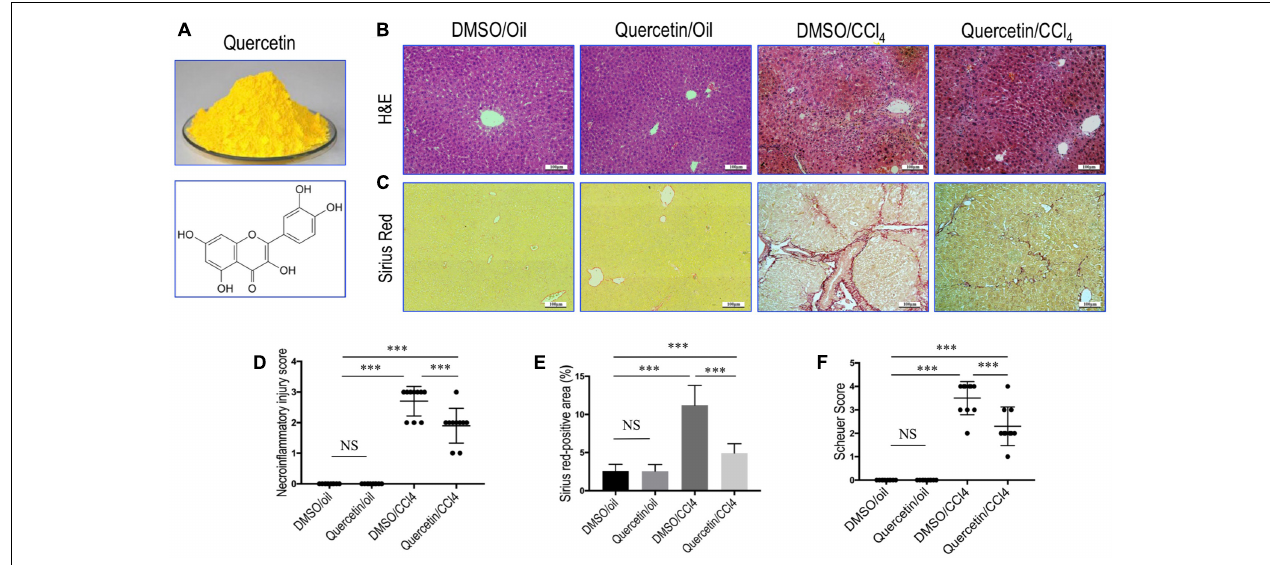
FIGURE 1 | Quercetin inhibited liver inflammation and fibrosis in CCl 4 -treated mice. (A) Quercetin powder and chemical structure of quercetin (3,3 (cid:48) ,4 (cid:48) ,5,7-pentahydroxyflavone). (B) Histological examination of liver sections from each group ( H&E staining, original magnification: × 100). Scale bar = 100 µ m. (C) Sirius red staining of liver sections (original magnification: × 100). Scale bar = 100 µ m. (D) The hepatocellular damage observed in H&E-stained liver sections were analyzed and scored as described under the section “Materials and Methods” ( n = 10/group). (E) Hepatic fibrotic area based on Sirius red staining. (F) Assessment of liver fibrosis based on Scheuer’s scoring system. ∗∗∗ P < 0.001; “NS” indicates not